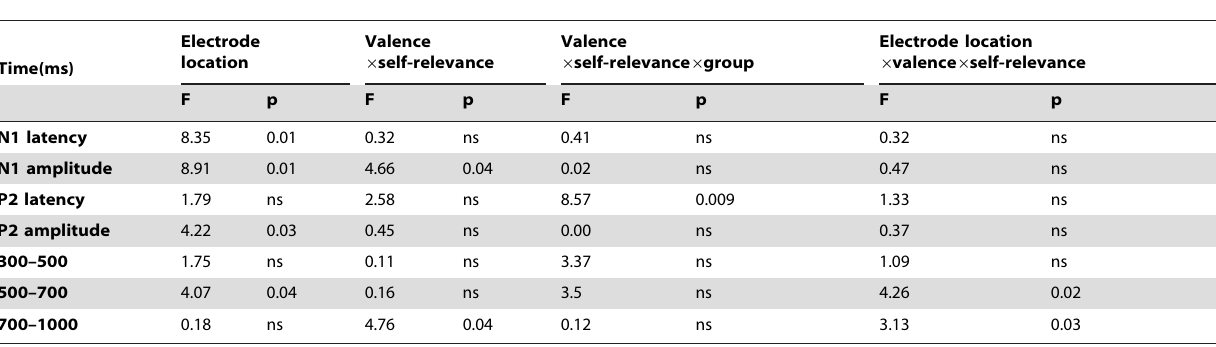
Table 2. Summary of results for the repeated measures ANOVAs for each of the time windows